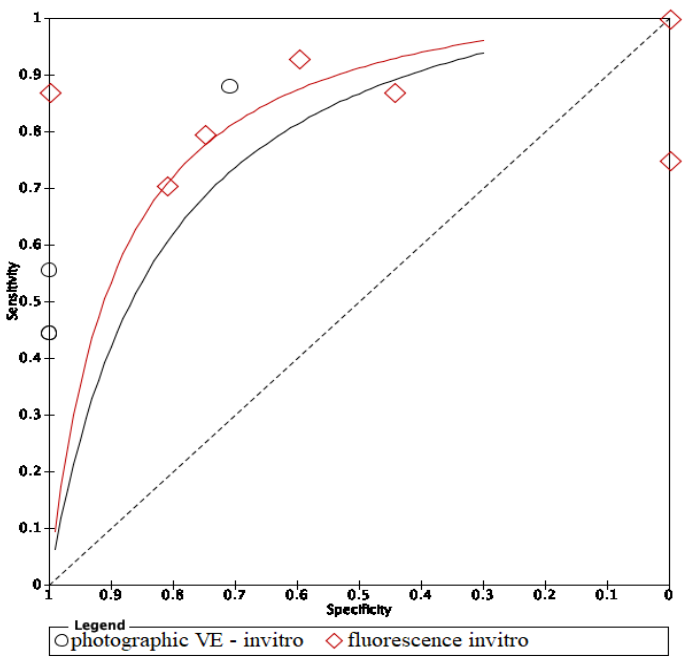
Figure 11. In vitro comparison of photographic visual examination and fluorescence.